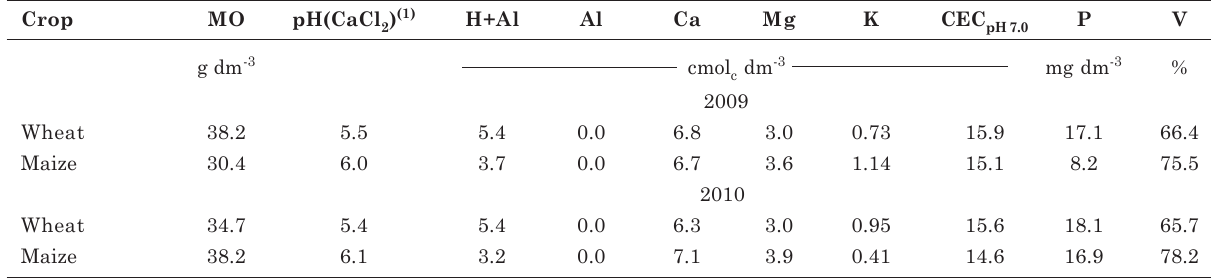
Table 1. Soil chemical properties in the 0-0.2 m layer in the experimental areas of wheat and maize in two study